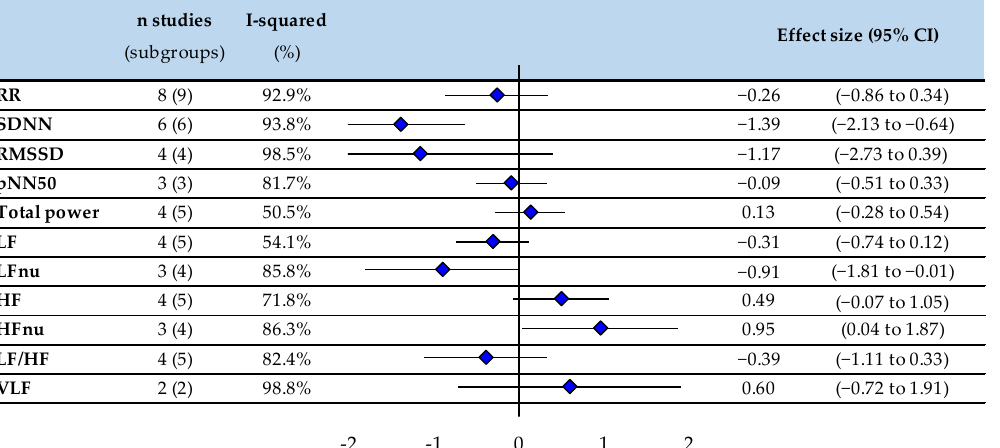
Figure 3. Meta-analysis of HRV parameters of treated hyperthyroid patients compared with healthy controls. RR: RR intervals (or normal-to-normal intervals-NNs), SDNN: standard deviation of RR intervals, pNN50: percentage of adjacent NN intervals differing by more than 50 milliseconds, RMSSD: the square root of the mean squared difference of successive RR-intervals, LF: low frequency, LFnu: low frequency normalized—units, HF: high frequency, HFnu: high frequency—normalized units, LF/HF ratio: low frequency/high frequency ratio, VLF: very low frequency, (cid:7) : effect size for all